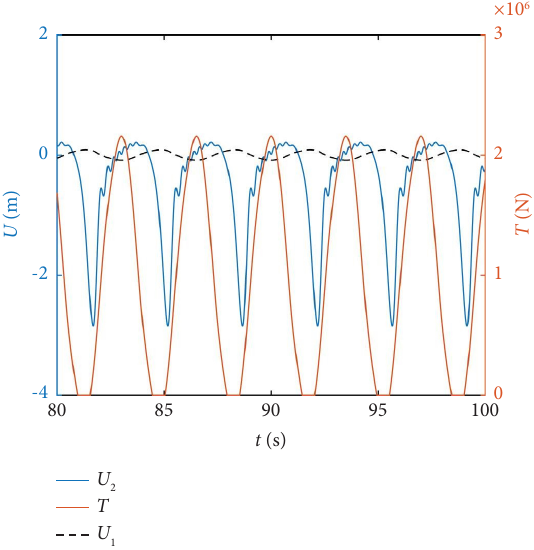
Figure 11: Time history of normal motion at 10m from anchor point.